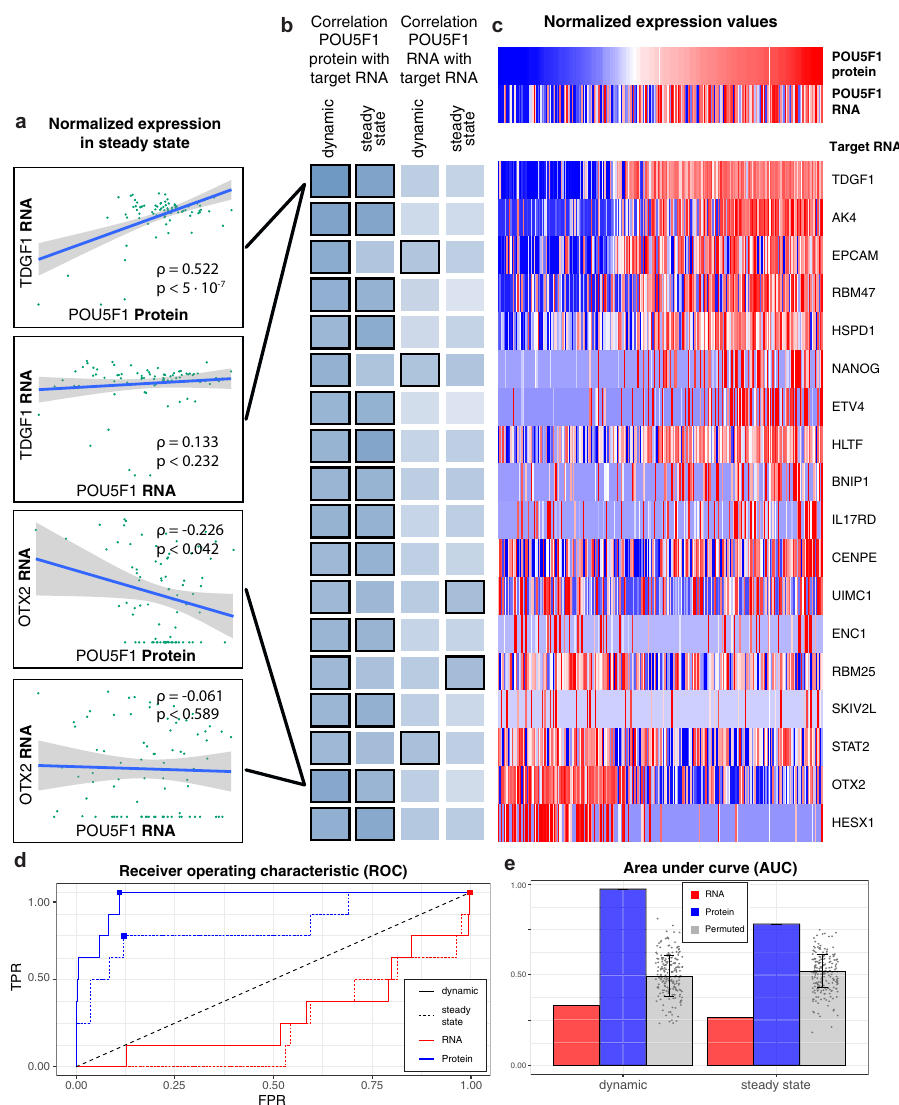
Fig. 3 Transcription factor protein but not mRNA correlates with target mRNA. a Scatter plot of POU5F1 expression in 0 h single cells (steady state), both at the level of RNA and protein compared to the RNA expression of POU5F1 regulatory target genes TDGF1 (upper panels) and OTX2 (lower panels). Blue line represents linear model between the two expression patterns. b Correlation between POU5F1 protein and RNA levels with the RNA expression of POU5F1 regulatory targets in steady state (0 h) or dynamic (0, 24, and 48 h) conditions. Darker shading indicates stronger correlation. Bold outlining indicates in which of the analysis groups the correlation was considered to be signi fi cant (FDR < 0.05). c Heatmap with expression levels of POU5F1 at the protein and RNA level and the RNA expression of POU5F1 regulatory target candidate genes. The color scale relates to high (red) and low (blue) expression. The columns in the heatmap are ordered based on the protein expression of POU5F1. d Red lines represent POU5F1 (protein) — target (RNA) ROC curves and blue lines represent POU5F1 (RNA) — target (RNA) ROC curves based on regulatory link weights. Solid line represents dynamic conditions, dotted lines indicate steady-state conditions. Filled squares represent the Youden index of the different ROC curves. e Quanti fi cation of total area under the curve for ROC (see Fig. 3d) including a permuted control of 200 permutations each AUC represented as a permutation test ( n = 200) with randomization of which genes (FPR), based on the number of positive targets, i.e., true positive that are the true targets (AUC = 0.50 ± 0.092) (Fig. 3e). As rate (TPR), identi fi ed. We did this using four different analysis expected, the AUC results show that using data from cells groups where we calculated the correlation between POU5F1 pro- undergoing a dynamic change gives better power to detect tein or POU5F1RNA and target RNA , and included either only steady- state (0 h) cells or all cells (0, 24, 48 h) (Fig. 3d, e). positive POU5F1 targets than only using data from steady-state, To estimate the power of the different correlation analysis and that this is true for correlation to either POU5F1 protein or POU5F1 RNA . Importantly, the results also show that groups, we calculated the area under the curve (AUC) of the ROC POU5F1 protein expression levels better predict regulatory targets curves, resulting in the following correlations: POU5F1 protein and target RNA with steady-state (AUC = 0.80) or all cells (AUC = than POU5F1 RNA levels. 0.97), correlation of POU5F1 RNA and target RNA with steady-state We next asked if we could identify POU5F1 regulatory targets that were not in our known candidate list. We did this by (AUC = 0.23) or all cells (AUC = 0.29) (Fig. 3e). To test what selecting the top fi ve percent correlated POU5F1 target pairs in values of AUC we would expect by chance, we performed a